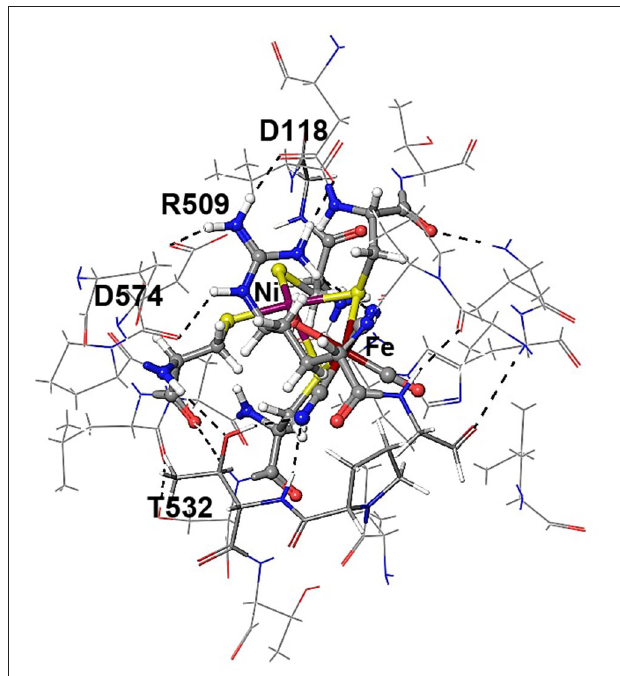
FIGURE 4 | Details of hydrogen bonding interactions of the active site of E. coli Hyd-1 with surrounding amino acid residues of the large subunit with a focus on the arginine residue 509. The N η 1 hydrogen atoms form hydrogen bonds with aspartate 118 and one of the cyanide ligands. The N η 2 hydrogen atoms make interactions with the aspartate residues 118 and 574. The terminal cyanide ligands are hydrogen bound to R509 side chain NH 2 and main chain NH protons; the second cyanide group accepts hydrogen bonds from the OH side chain and the NH main chain protons of